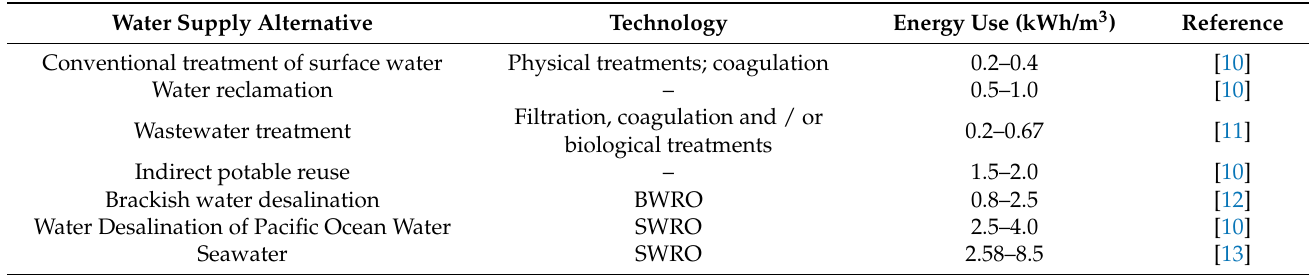
Table 1. Energy consumption for different water